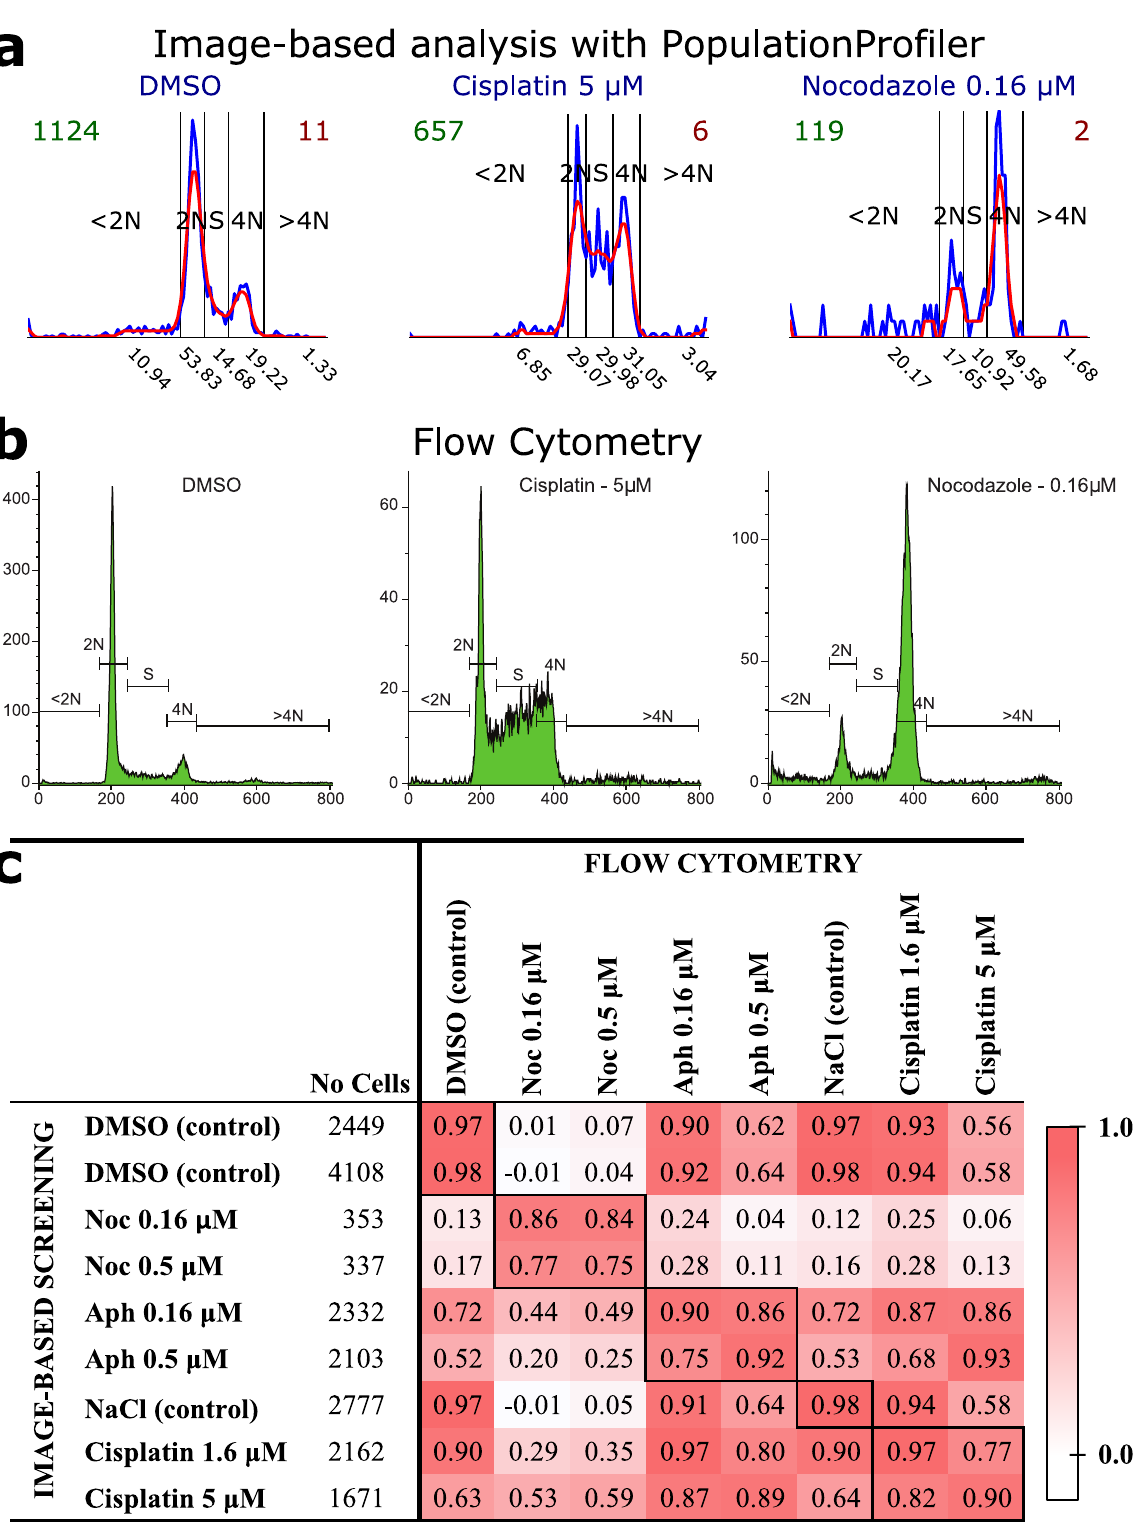
PLOS ONE | DOI:10.1371/journal.pone.0151554 March 17,